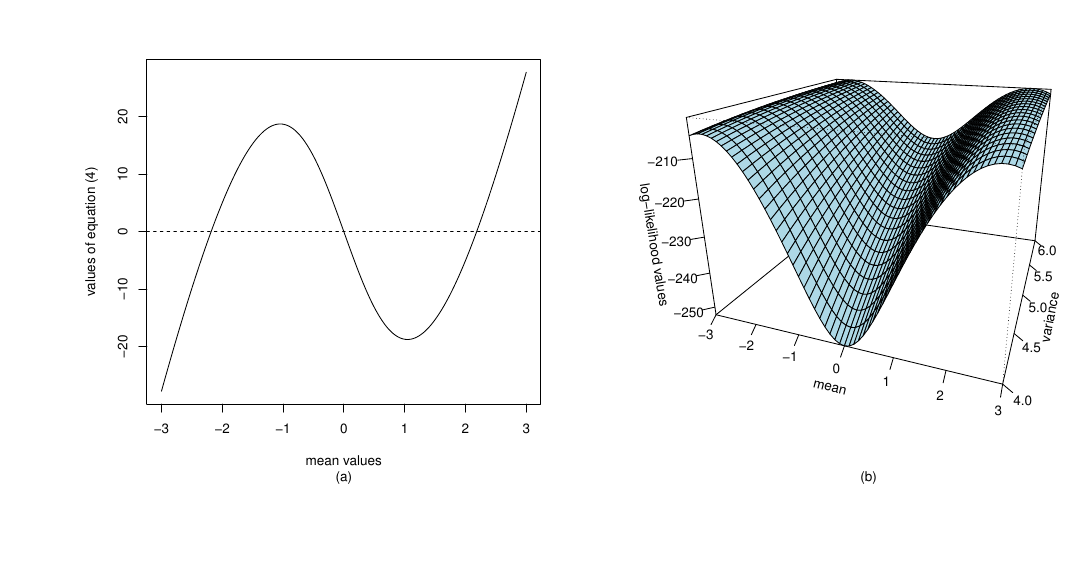
Figure 5. The left graph ( a ) shows the three solutions of the log-likelihood. The right three-dimensional figure ( b ) shows the values of the log-likelihood for a range of mean and variance